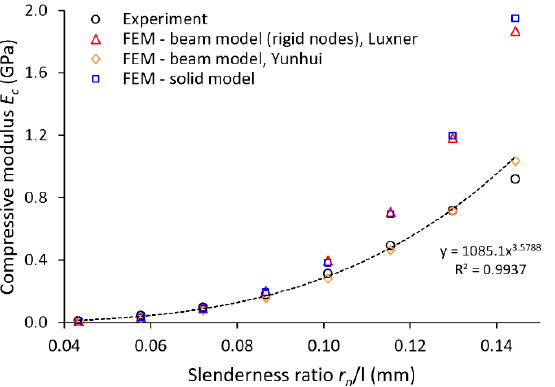
Figure 12. Comparison of lattice structure compressive modulus with a numerical solution.